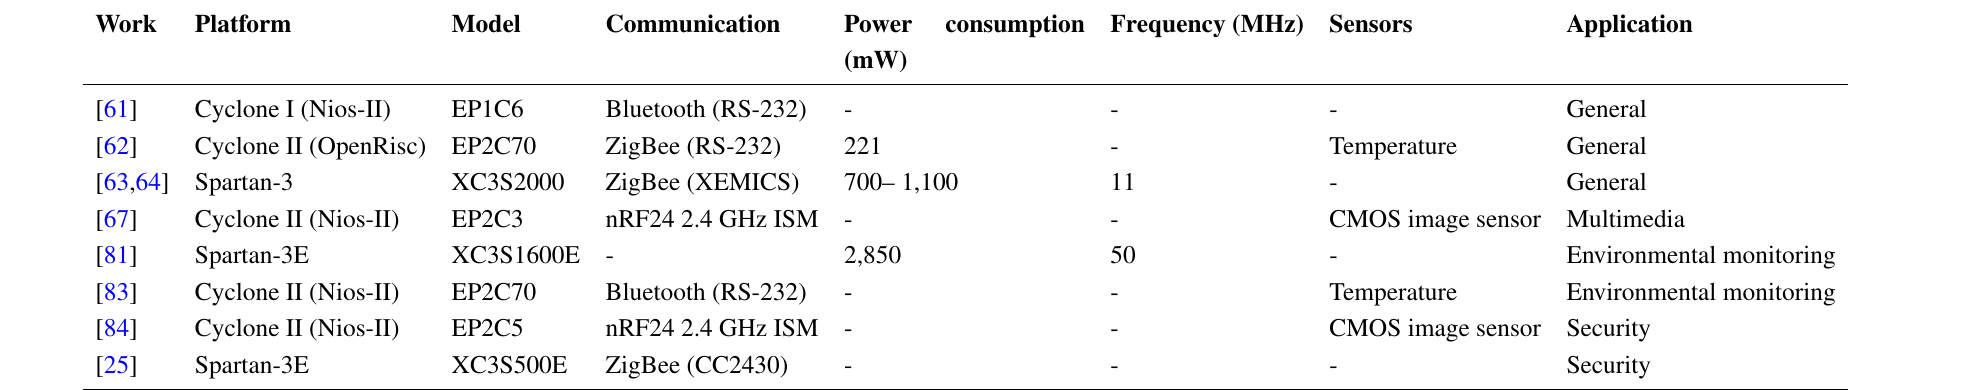
Table 6. FPGA Standalone sensor nodes.